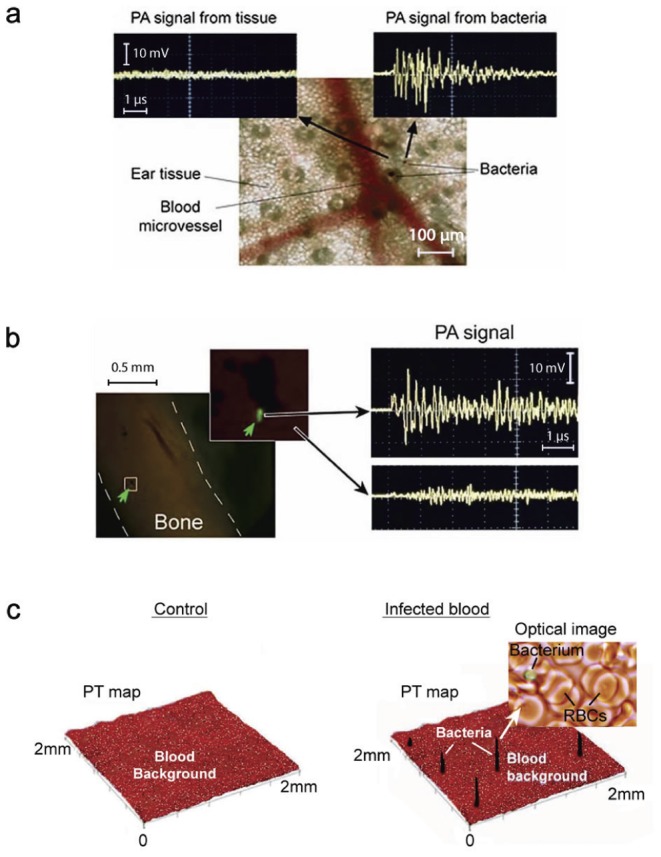

In vivo monitoring of labeled bacteria in tissue.(a) In vivo monitoring of bacterial extravasation from a mouse ear vein. (b) Arrest of circulating bacteria in mouse tibial bone labeled in vitro with 30-nm MNPs functionalized with FITC-conjugated Abs (left). The presence of bacteria in bone was confirmed by the appearance of PA signals after fluorescence-guided laser irradiation of green spots (right, top) compared to background signals from bone alone (right, bottom). (c) PT map of a 120-µm slide containing blood spiked with bacteria labeled with anti-Spa-Ab-conjugated GNTs900. Black peaks are associated with single bacteria as verified by optical imaging (callout). Laser parameters: wavelengths, 639 nm (a, b, c); energy fluence, 0.1 J/cm2.